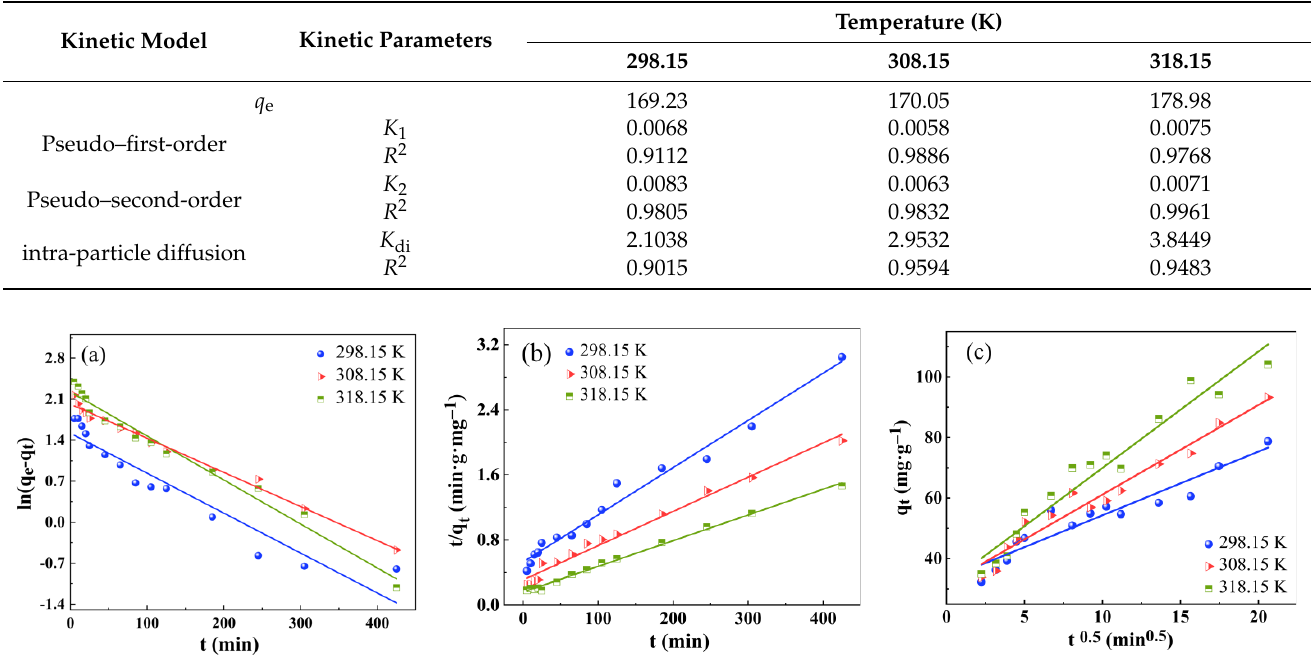
Table 2. Adsorption kinetic parameters of RhB on hydrophobic ZrO 2 -SiO 2 xerogel at various temperatures.